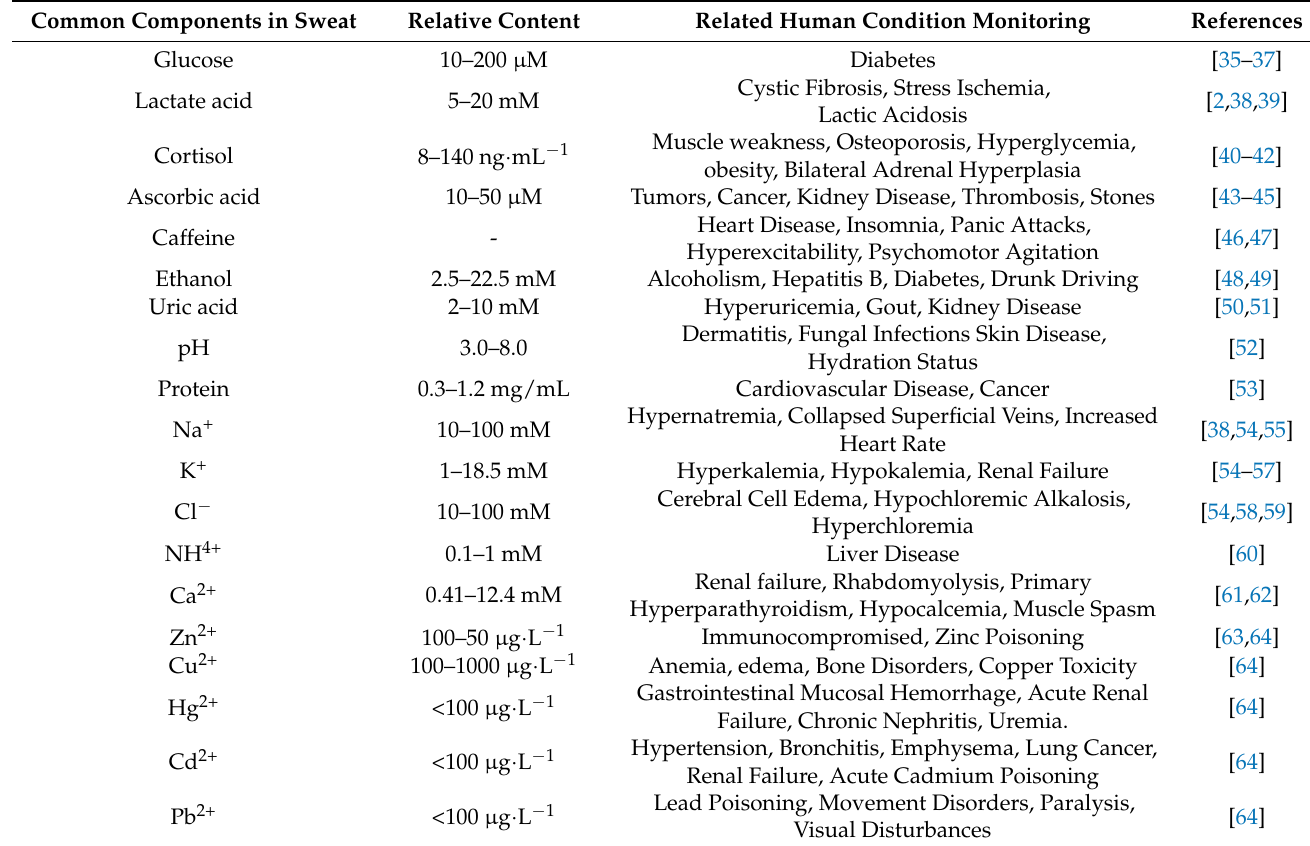
Table 1. The common components and relative contents in sweat and related